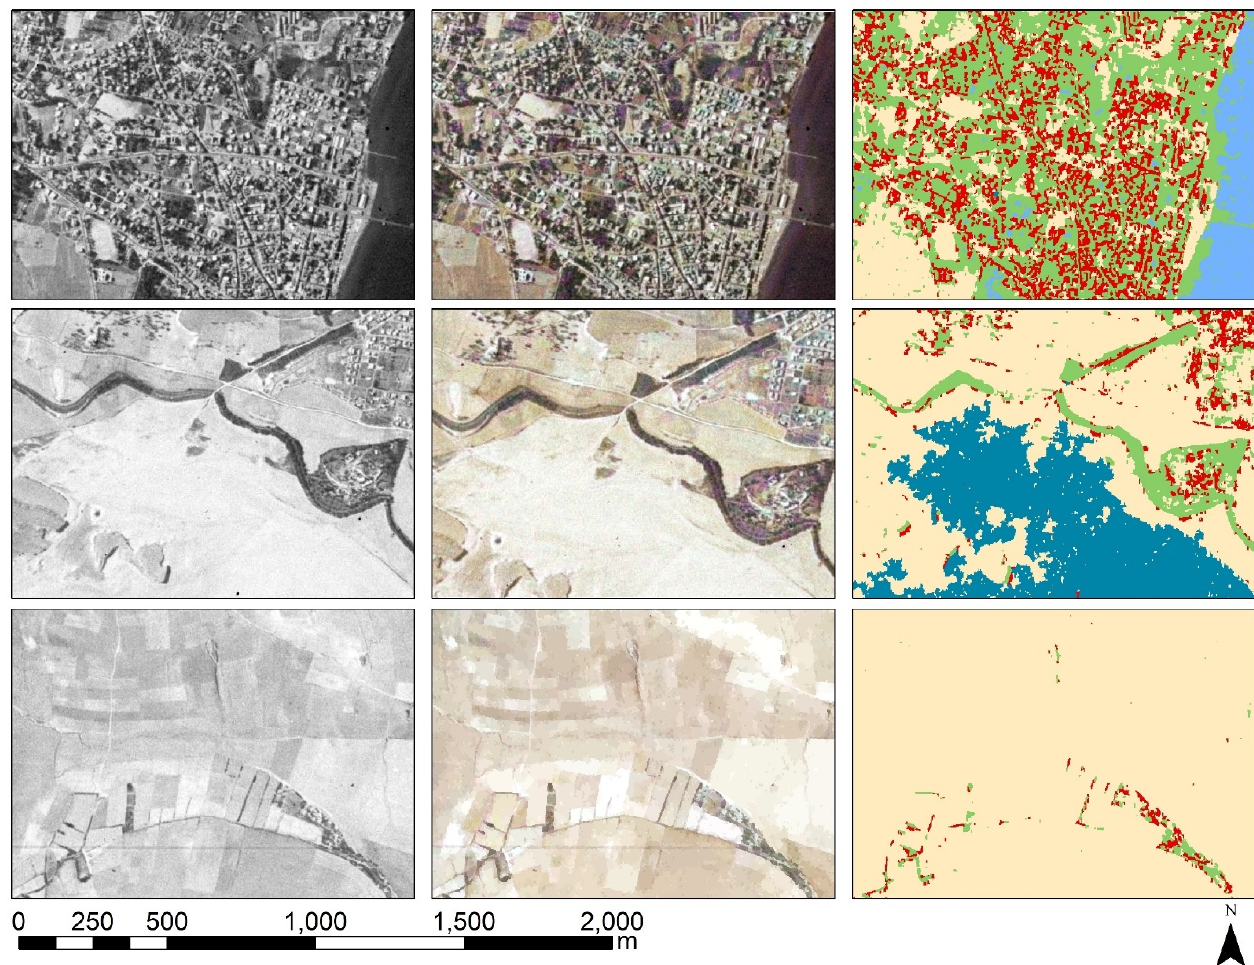
Figure 6. A closer look over the classification results as indicated in Figure 5. The first row displays the results over Larnaca urban area. The second row shows the results over the Salt Lake of Larnaca. Finally, the third row shows an example from the agricultural fields in the western part of the image. The first column shows the results of the original CORONA image, the second column the colourised CORONA image and the third colour the classification outcomes with the different thematic classes. The colours are the same as in Figure 5.